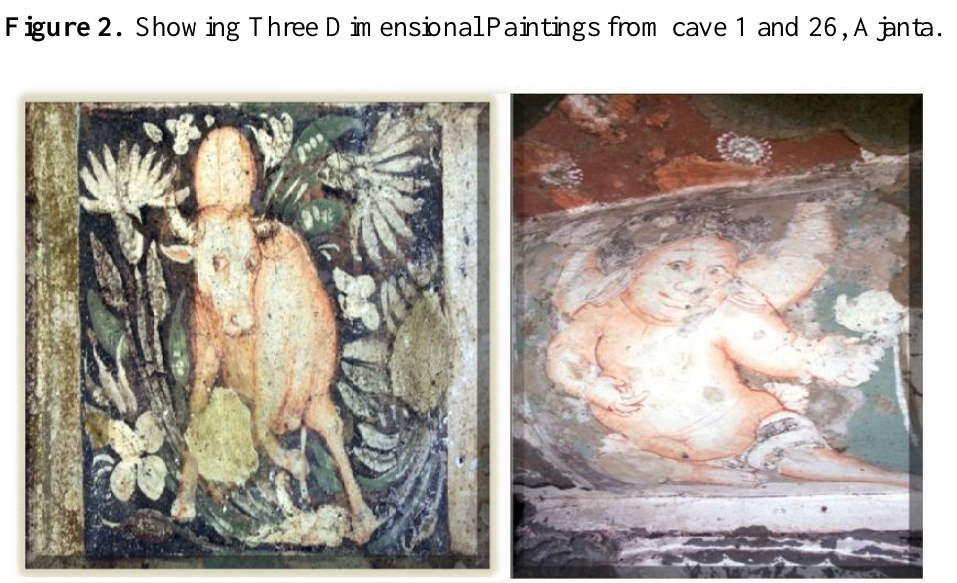
Figure 2. Showing Three Dimensional Paintings from cave 1 and 26,